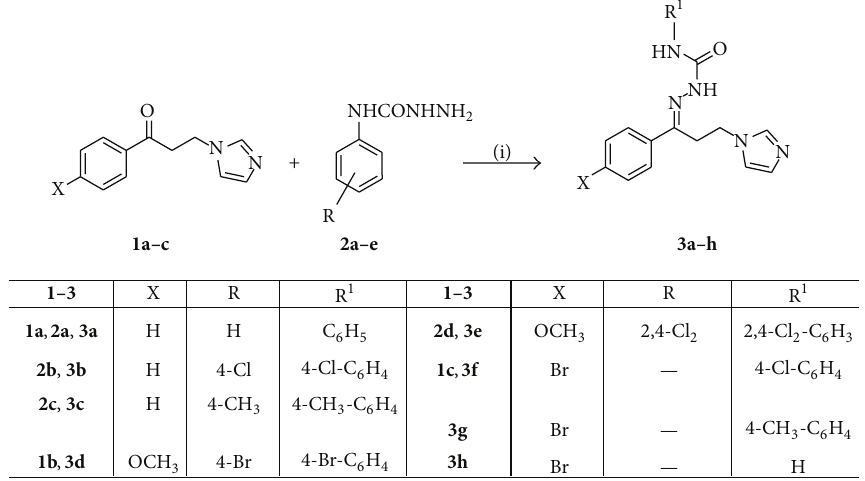
Scheme 1: Synthetic protocol to achieve test compounds 3a – h . Reagents and conditions: (i) ethanol, acetic acid, RT, 18hrs or semicarbazide hydrochloride, anhydrous sodium acetate, ethanol, RT, 18hrs for 3h